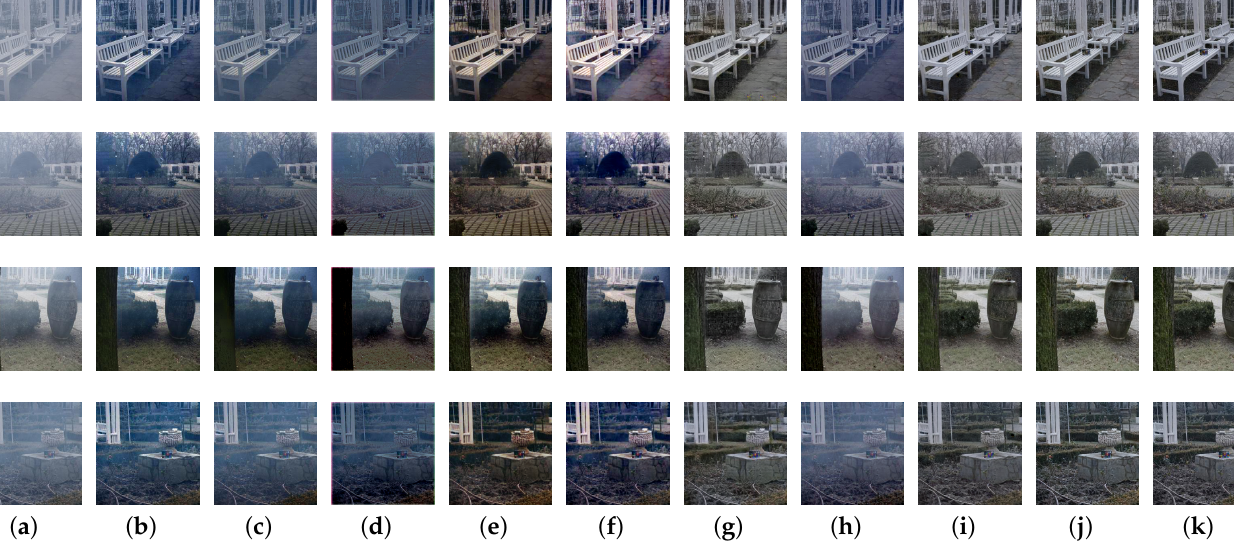
Figure 12. Visual comparisons on the NTIRE dehazing challenge datasets: ( a ) hazy images; ( b ) DCP; ( c ) CAP; ( d ) AODNet; ( e ) EPDN; ( f ) GCANet; ( g ) pix2pix; ( h ) FFA-Net; ( i ) two-branch; ( j ) our proposed method; ( k ) corresponding haze-free